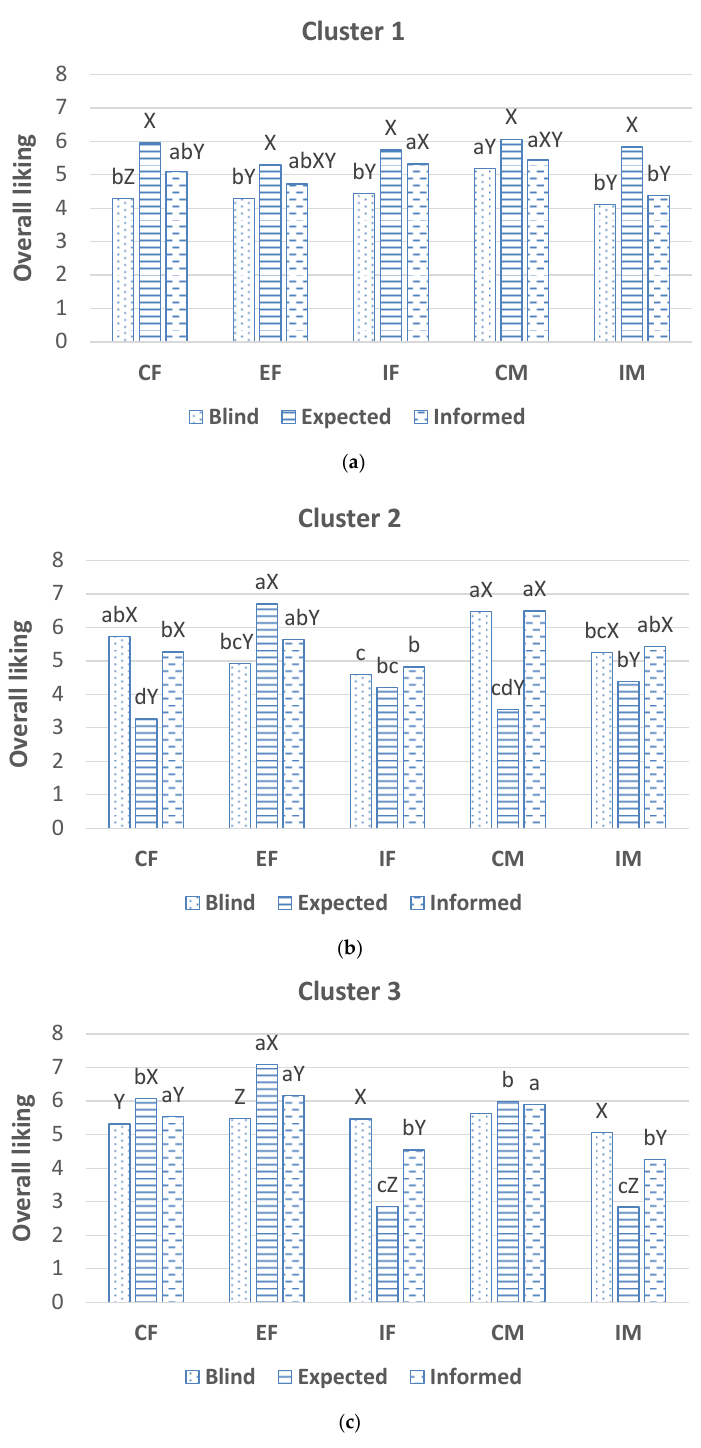
Figure 2. Acceptability scores by consumers of Cluster 1 ( a ), Cluster 2 ( b ) and Cluster 3 ( c ) of pork from surgically castrated females (CF), entire females (EF), immunocastrated females (IF), surgically castrated males (CM) and immunocastrated males (IM) obtained from the evaluation in blind conditions, as expectations and from the evaluation of meat in informed conditions according to a scale from 0 (Extremely dislike/I think I would dislike it extremely) to 10 (Extremely like/I think I would like it extremely). Different letters, a,b,c,d indicate significant differences between sex type within condition of information, and different letters X,Y,Z indicate significant differences between conditions of information and within sex type.